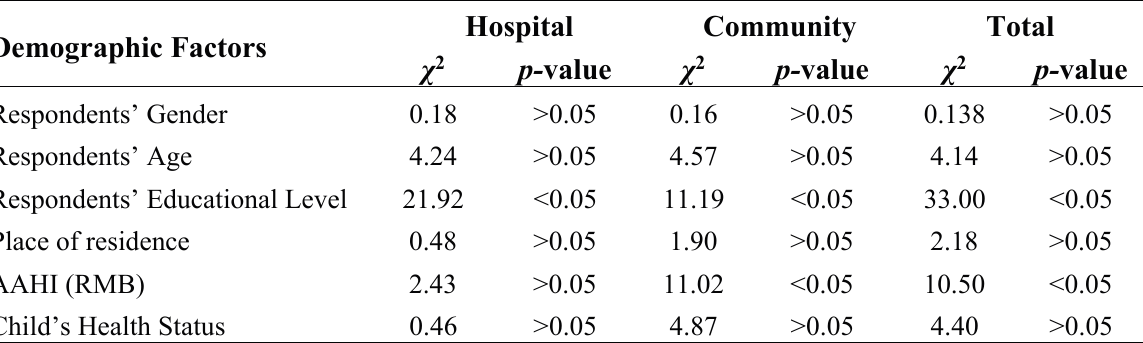
Table 2. Respondents’ general awareness rate of knowledge towards air pollution to children’s respiratory health.